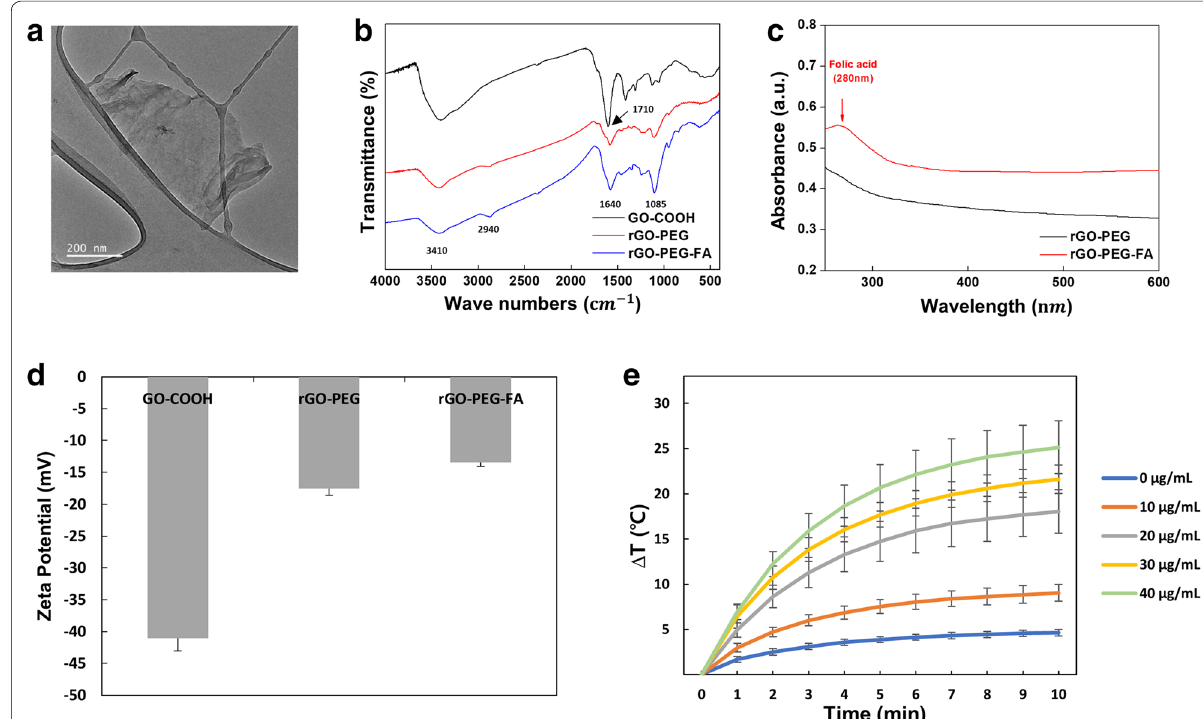
Fig. 2 Characterization of nanomaterials. TEM image of rGO‑PEG‑FA nanomaterials ( a ). Scale bars are 200 μm. FT‑IR spectra of GO‑COOH, rGO‑PEG, and rGO‑PEG‑FA nanomaterials ( b ). UV–visible spectra rGO‑PEG, and rGO‑PEG‑FA nanomaterials ( c ). Zeta potential analysis of GO‑COOH, rGO‑PEG, and rGO‑PEG‑FA nanomaterials ( d ). Temperature analysis against concentrations of rGO‑PEG‑FA nanomaterials ( e